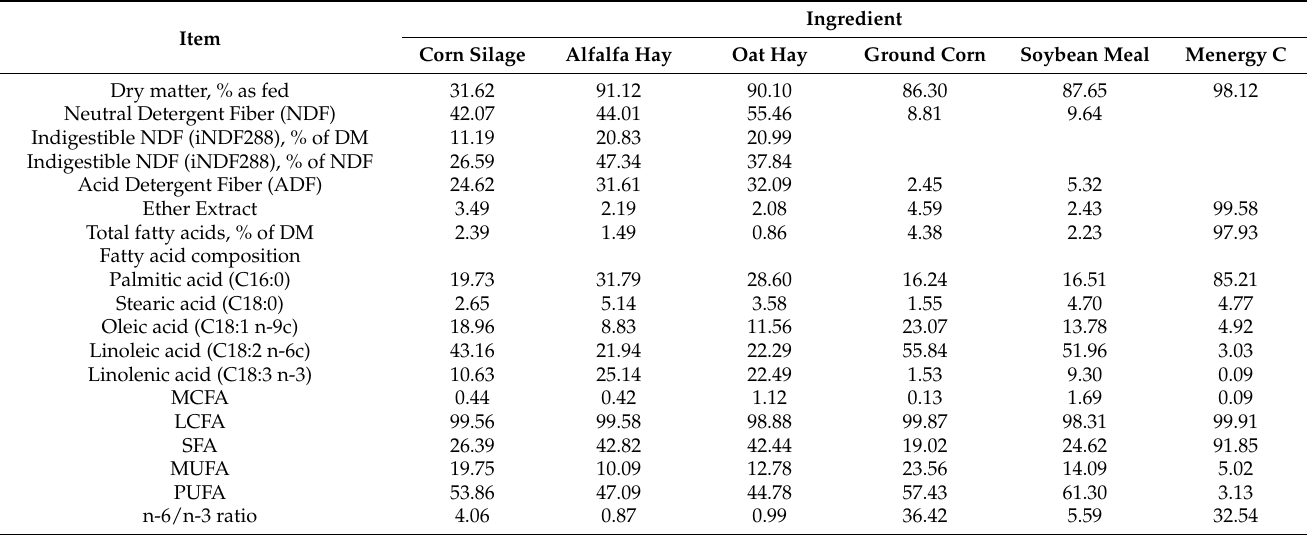
Table 2. The chemical composition (% of DM unless otherwise noted) and fatty acid profile (% of total FA) of the varied